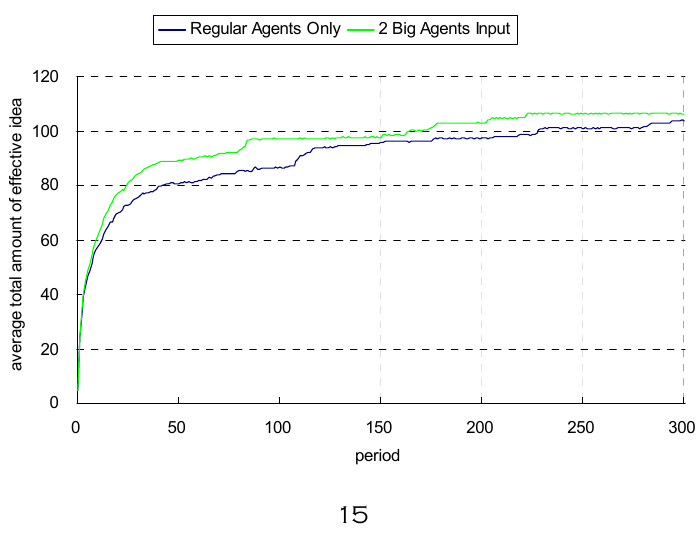
Figure 4. Average Total Amount of Effective